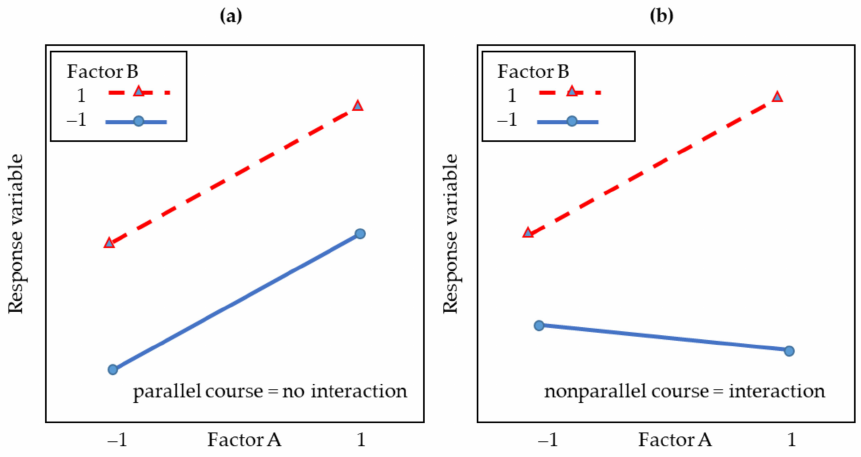
Figure 6. Own illustration of interactions according to [39,40]; mean values of the factors are shown; the degree of nonparallelism of the effect lines is an indicator of the intensity of the interaction. If the effect lines are parallel ( a ), there is no interaction. If they are nonparallel ( b ), there is an